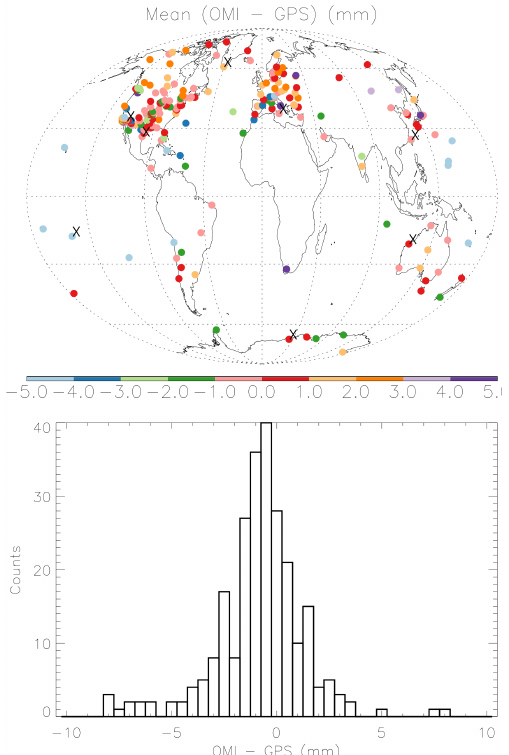
Figure 3. Top: spatial distribution of the mean of version 1.0 OMI − GPS from 2005 to 2009 at IGS-SuomiNet stations. Bottom: histogram (with 0.5mm bins) for the values in the top panel.